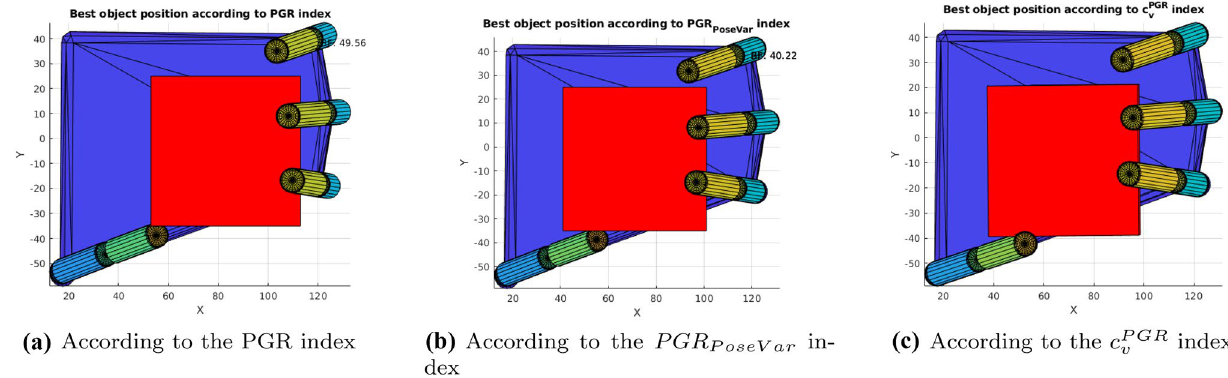
Fig. 22 The best power grasp for an 60mm edge